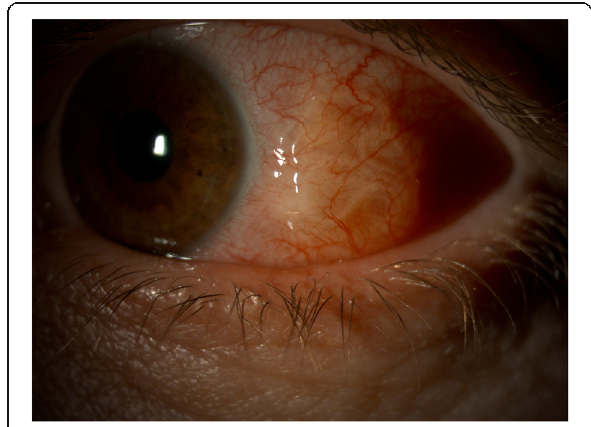
Fig. 1 The worm is seen in the temporal part of the bulb under the